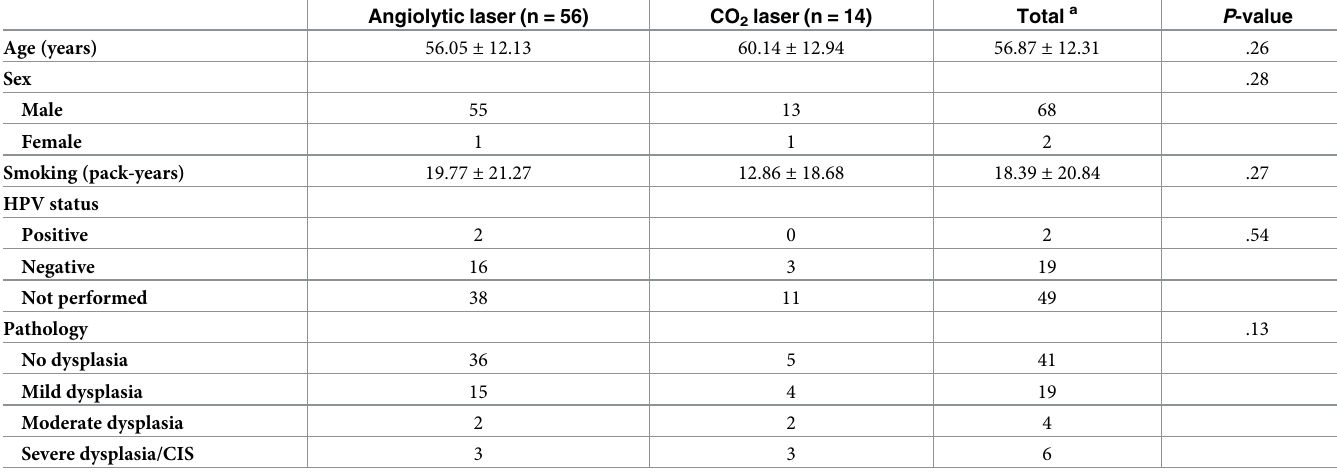
Table 1. Clinical information and treatment outcomes of all